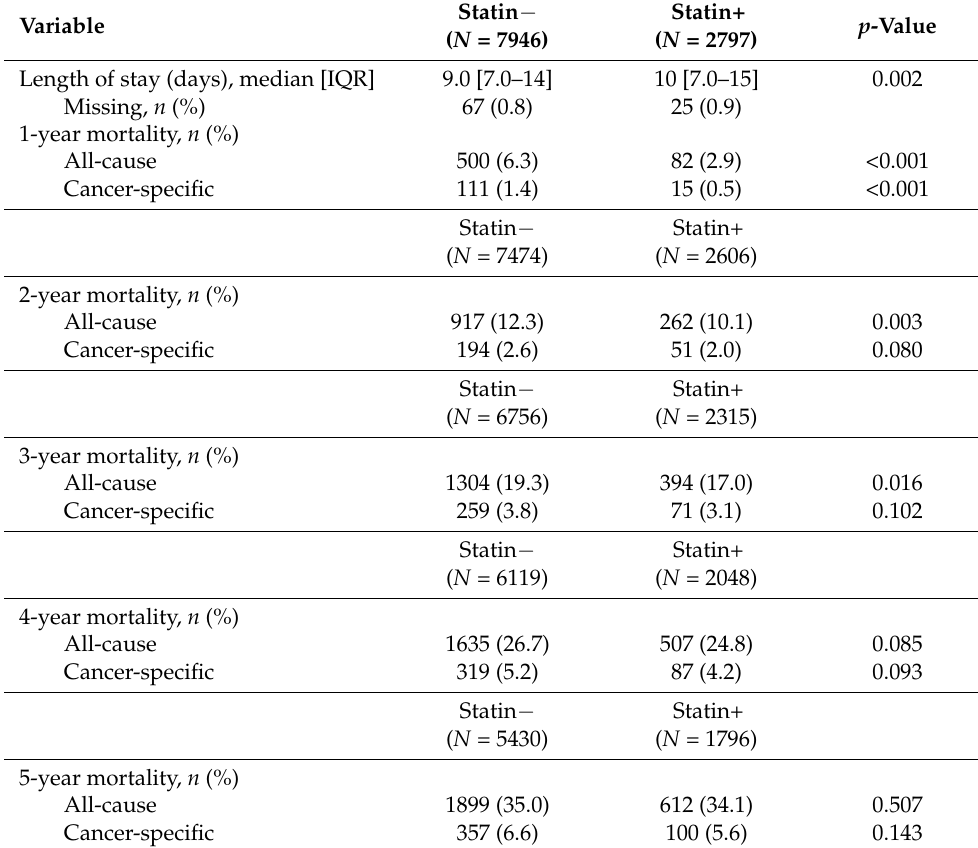
Table 3. Crude postoperative outcomes.